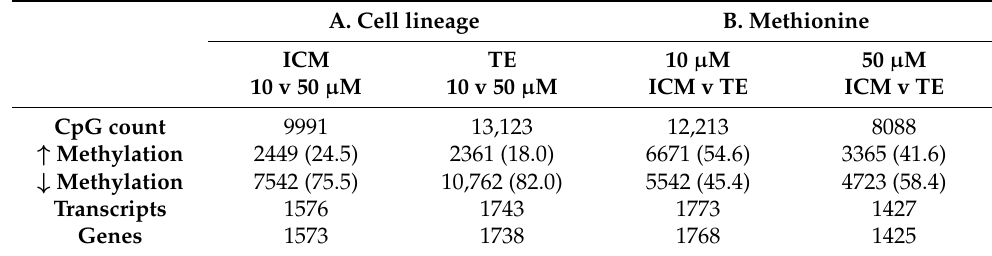
Table 2. Differentially methylated cytosine-phosphate-guanine dinucleotide (CpG) counts, transcripts and genes between added methionine concentrations (10 v 50 µ M) within embryonic cell lineage ( A ), and embryonic cell lineage within methionine concentrations ( B ). Arrows indicate gain ( ↑ ) and loss ( ↓ ) of methylation at 10 compared to 50 µ M methionine and in inner-cell mass (ICM) compared to trophectoderm (TE) cells (percentage altered in